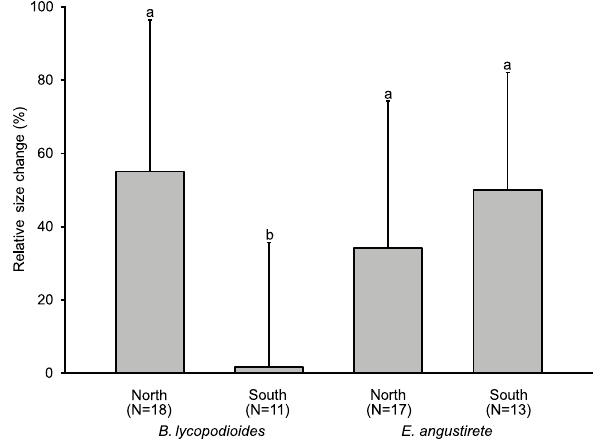
Figure 3. Mean growth (percentage ± 1 SD) of B.lycopodioides and E.angustirete at north- and south-facing slopes. Significant differences (at p , 0.05) between the two groups for each species are indicated with the symbols a–b.